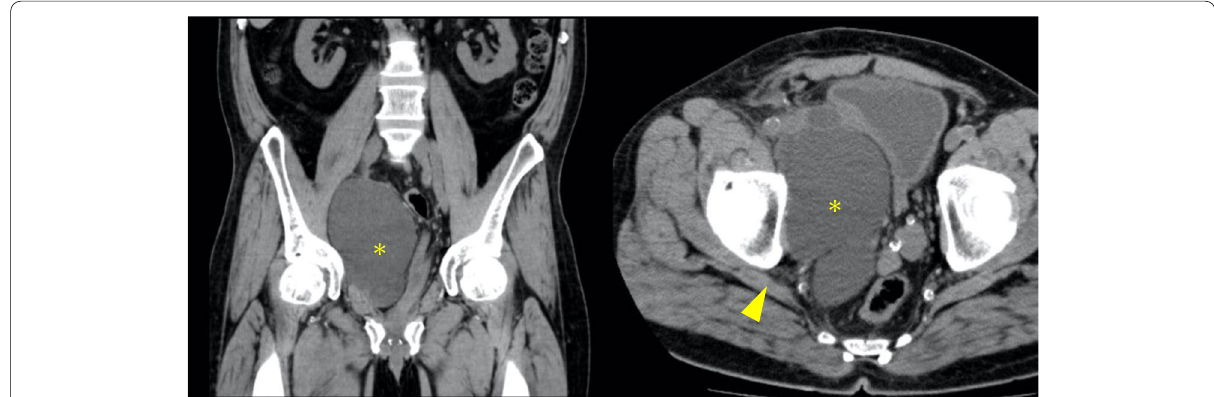
Fig. 1 Computed tomography of the pelvis. The coronal scan shows a huge lymphocele with low signal intensity (*). The axial scan shows that a lymphocele (*) compresses the piriformis muscle